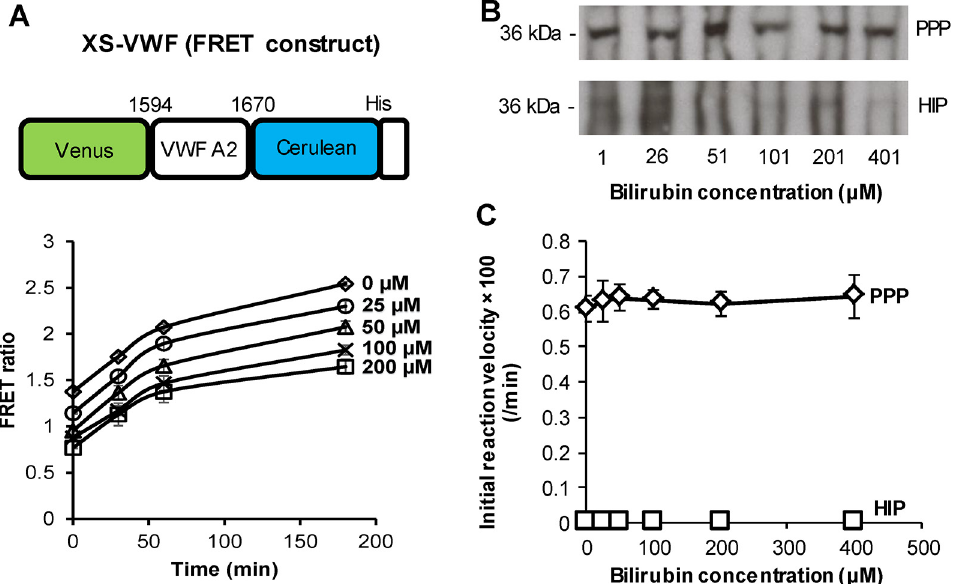
Fig 6. Effect of bilirubin on measurements of ADAMTS13 activity using XS-VWF and A2-77p-long. A. XS-VWF consists of Venus and Cerulean flanking the VWF-A2 77 amino acid peptide (residues 1594 – 1670). Substrate FRET ratio increases upon proteolysis. Here, 0.5 μ M XS-VWF was incubated with 25% normal human plasma containing different concentrations of recombinant bilirubin (0 – 400 μ M). Baseline FRET ratio at t = 0s decreased upon increasing bilirubin dose. B. XS-VWF samples obtained at 60min. in panel A were analyzed using western blots and anti-tetra His antibody to detect the ~36kDa substrate cleavage band. Equal substrate proteolysis was detected independent of bilirubin in plasma (top). No proteolysis occurred in runs with HIP (bottom). C. A2-77p-long microspheres were incubated with 25% plasma (or 25% HIP) at different bilirubin concentrations (0 – 400 μ M). Substrate cleavage measured using flow cytometry was unaffected by